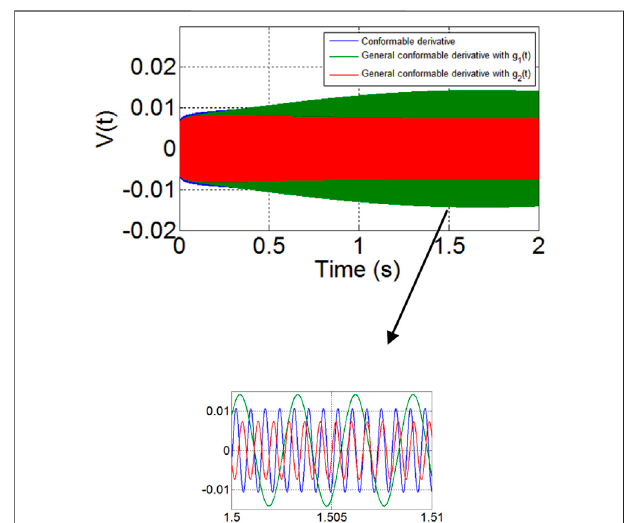
FIGURE 9 | Evolution of V ( t ) with α (cid:2) 0 . 98.